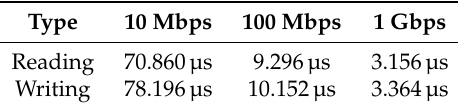
Table 3. COEsec processing